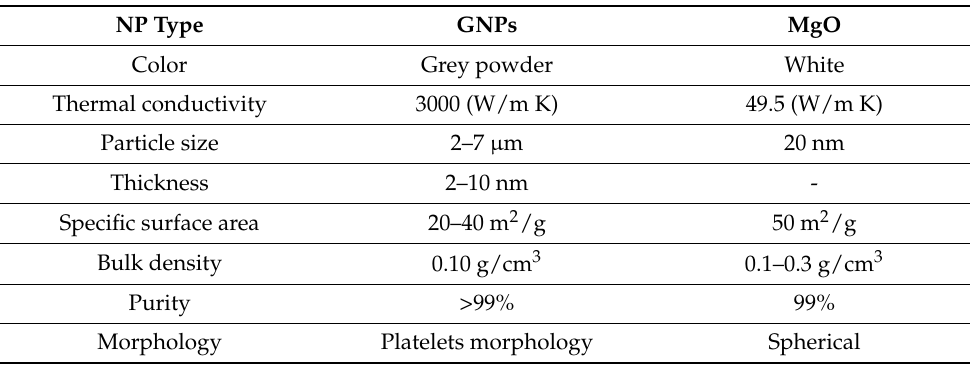
Figure 6. TEM images of GNPs [23] and MgO NPs [24]. Table 2. Nanoparticles Properties